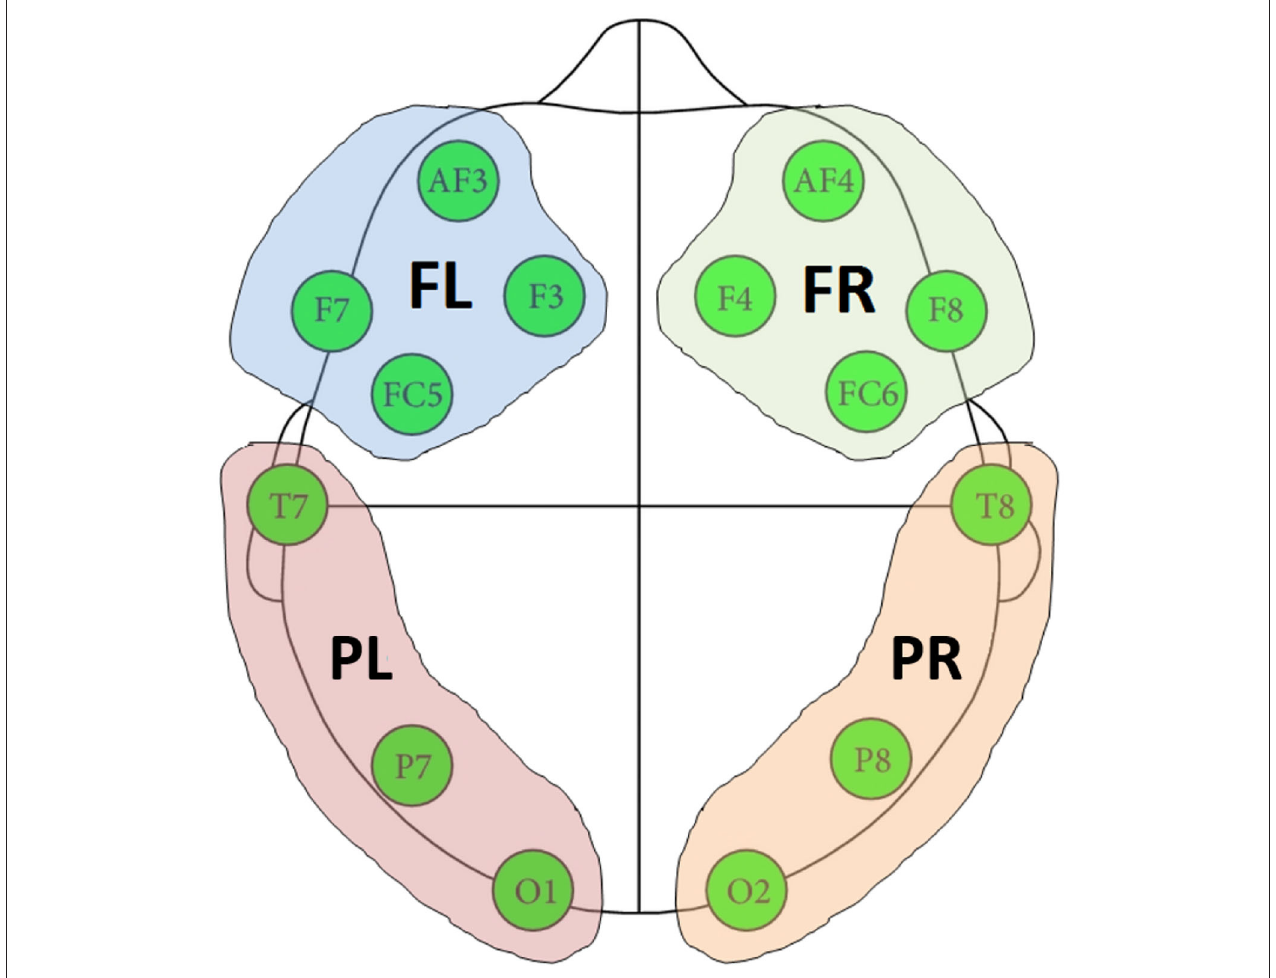
FIGURE 4 | Four regions formed based on the location of EEG channels. FR, frontal right; FL, frontal left; PR, posterior right; PL, posterior